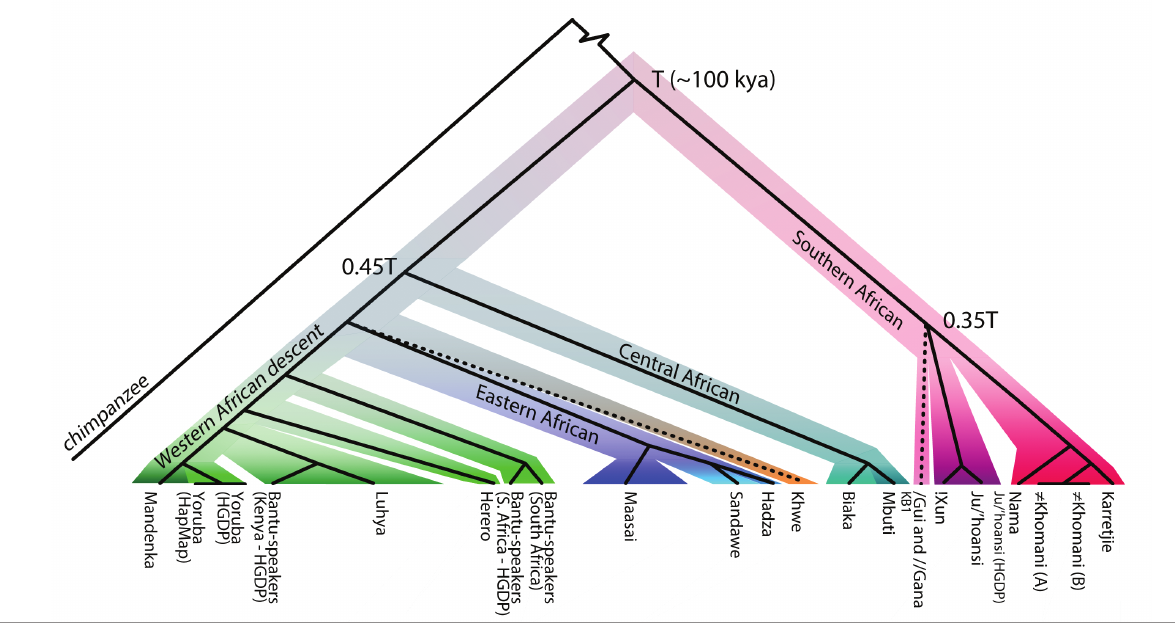
South African Journal of Science http://www.sajs.co.za